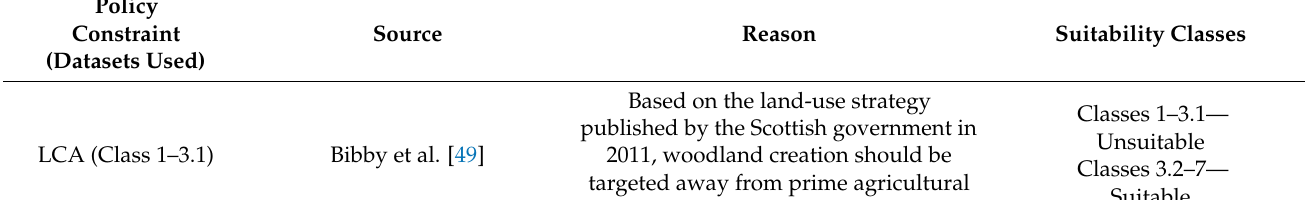
Table 5. Data, source, reason, and suitability classes used for policy constraint